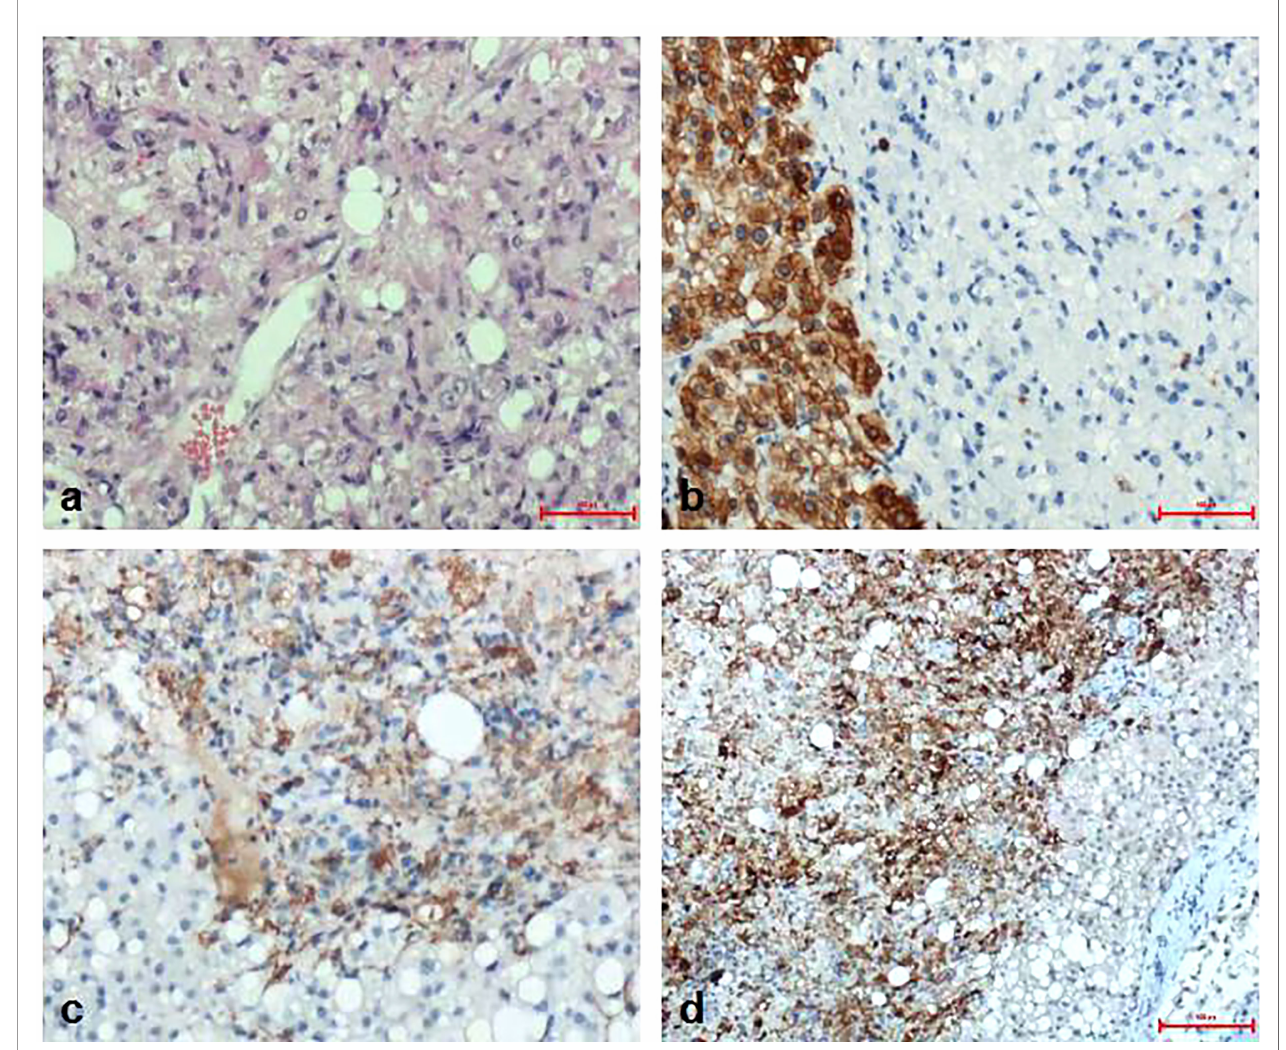
FIGURE 4 | Pathology result of the liver. (A) The boundary between the liver tumor and the surrounding liver tissue was unclear. The tumor was the mixture of epithelioid cells, perivascular muscle-like cells and adipocytes in different proportions; (B) Immunohistochemistry CK (hepatocyte+); (C) Immunohistochemistry Melan A(+); (D) Immunohistochemistry SMA